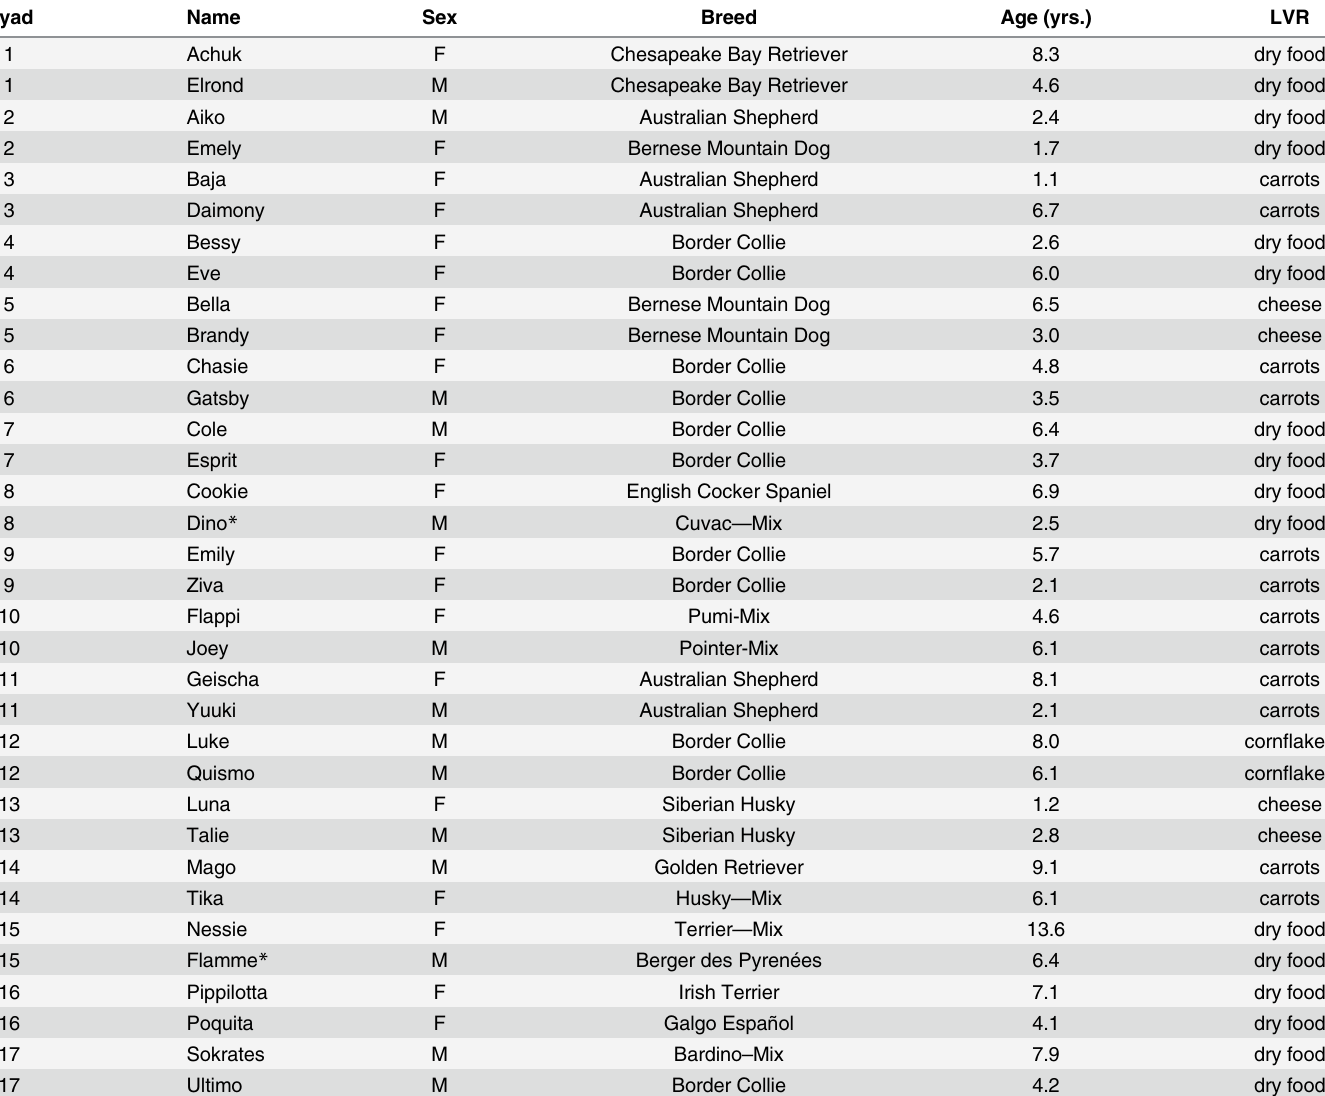
Table 1. Individual characteristics of dogs that completed testing ( N = 34) and low value rewards (LVR) used in each